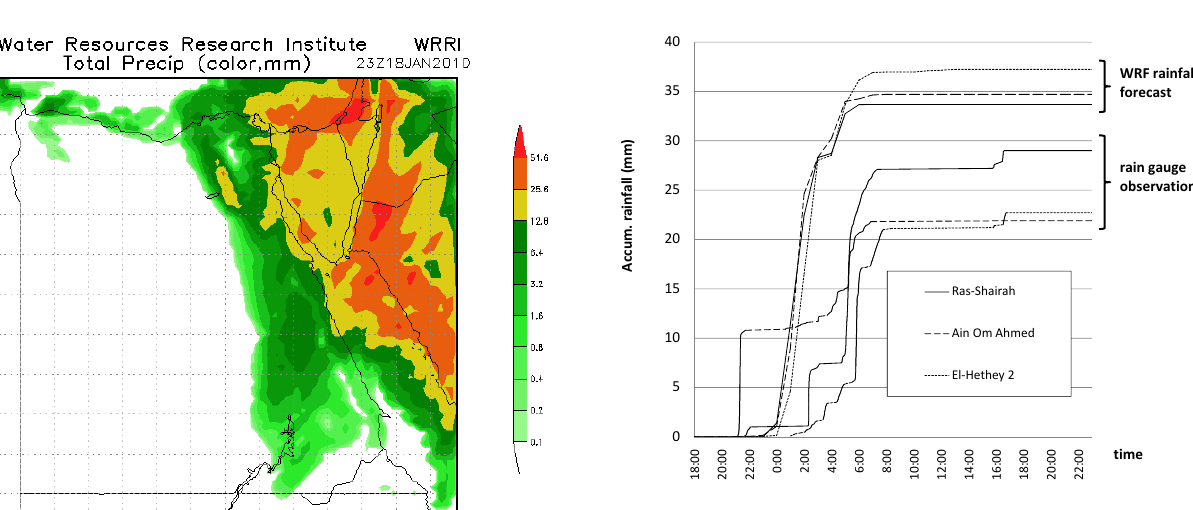
Fig. 10. Forecasted and measured rainfall in 3 stations for the Jan- uary 2010 event.